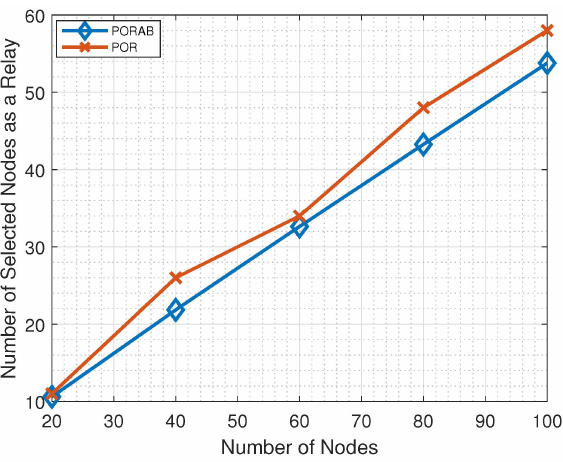
Figure 6. Variation of the number of selected relays with the number of nodes.